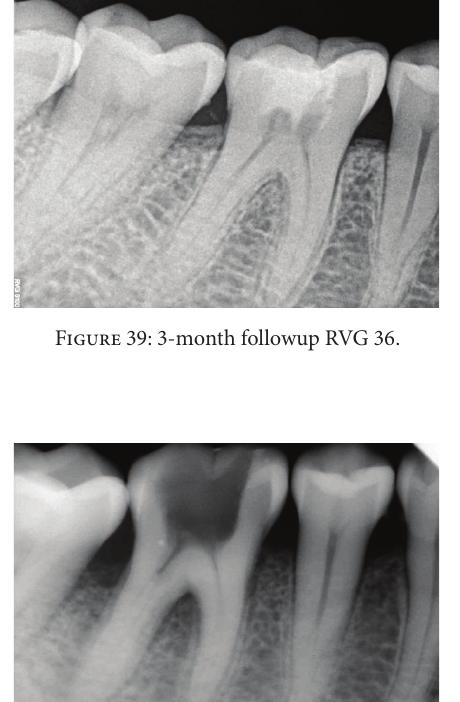
Figure 35: Placement of PRF membrane over the radicular pulp 36.